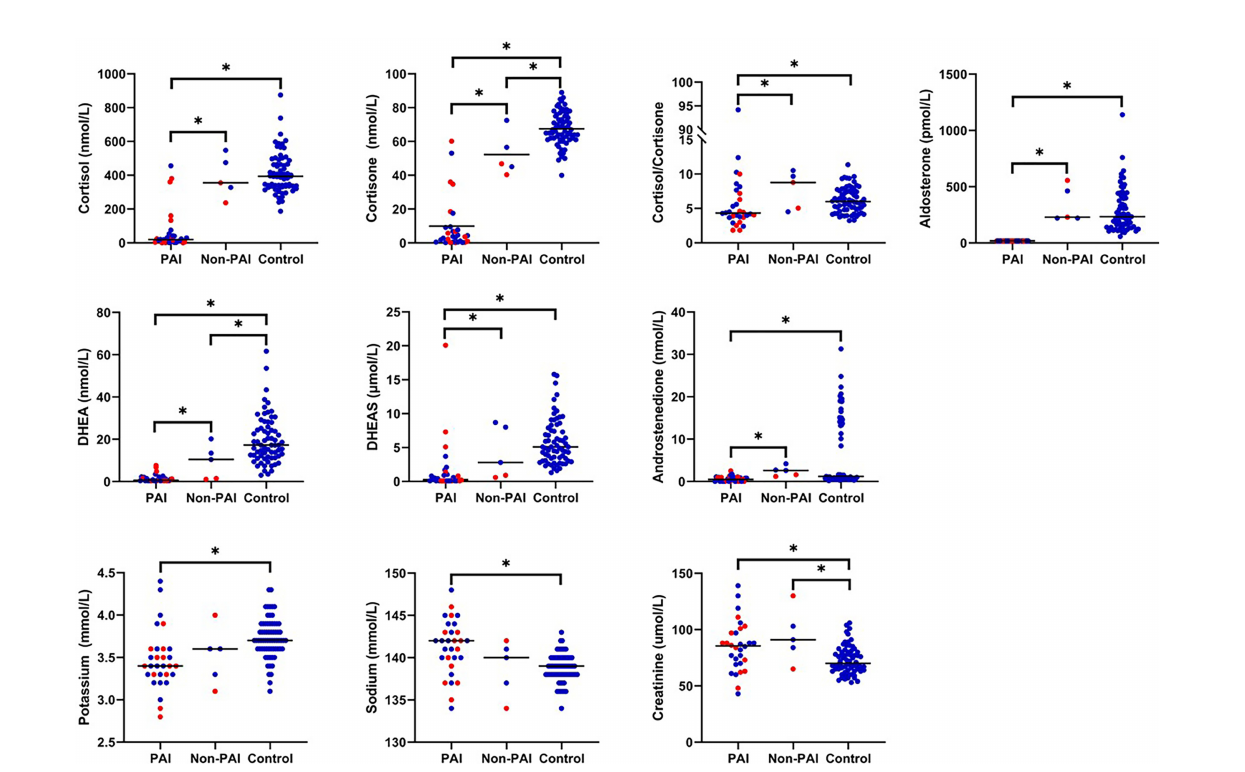
FIGURE 3 | Concentrations of adrenal steroids and electrolytes in adult patients with PAI due to APECED (n=30), adult patients with APECED without PAI (Non-PAI, n=5), and healthy adult controls (n=68). Fourteen patients with tendency for hypokalemia are marked in red. *p <